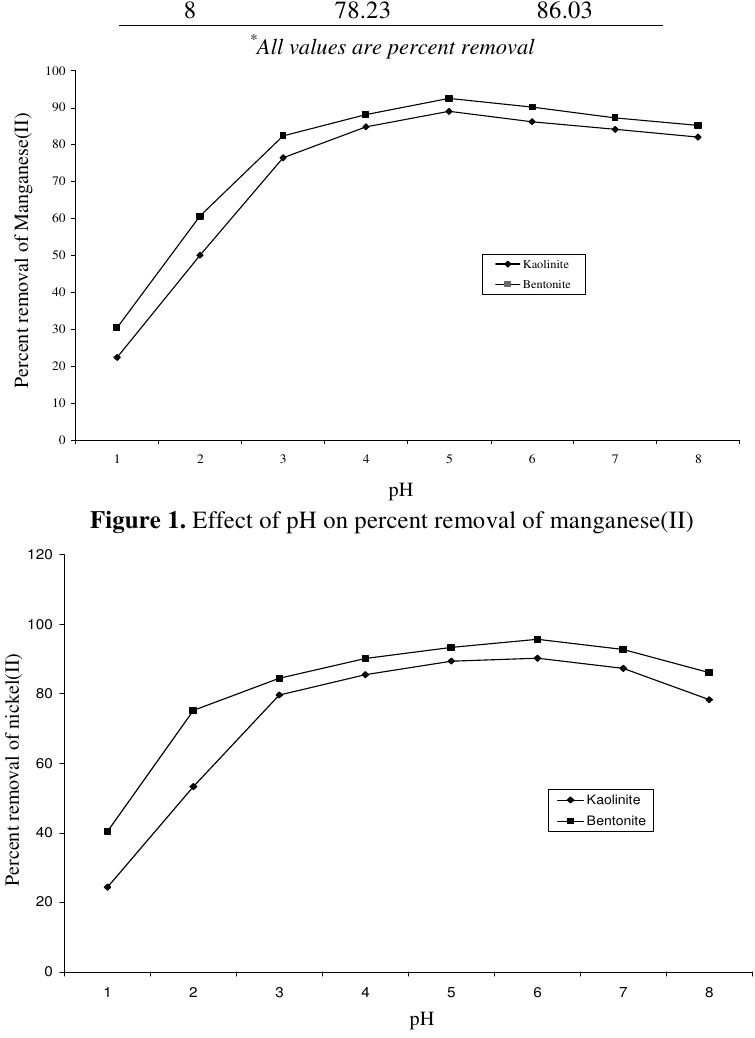
Figure 2. Effect of pH on percent removal of